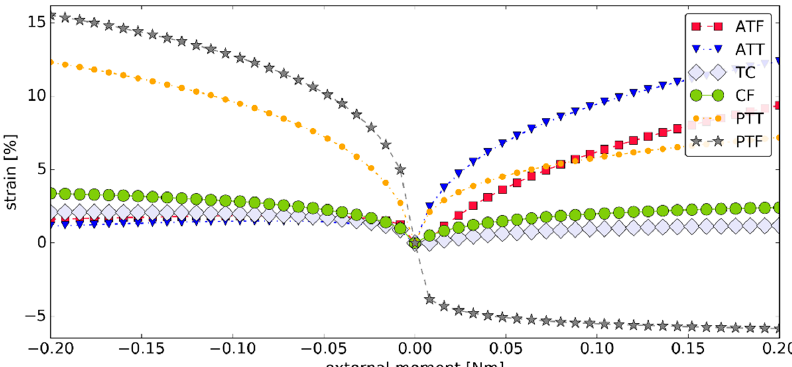
Figure 5. The strains within the ligaments as seen in the sagittal plane versus the external moment M ext in simulation #1 (negative [positive] strain corresponded to an inactive [active] ligament).